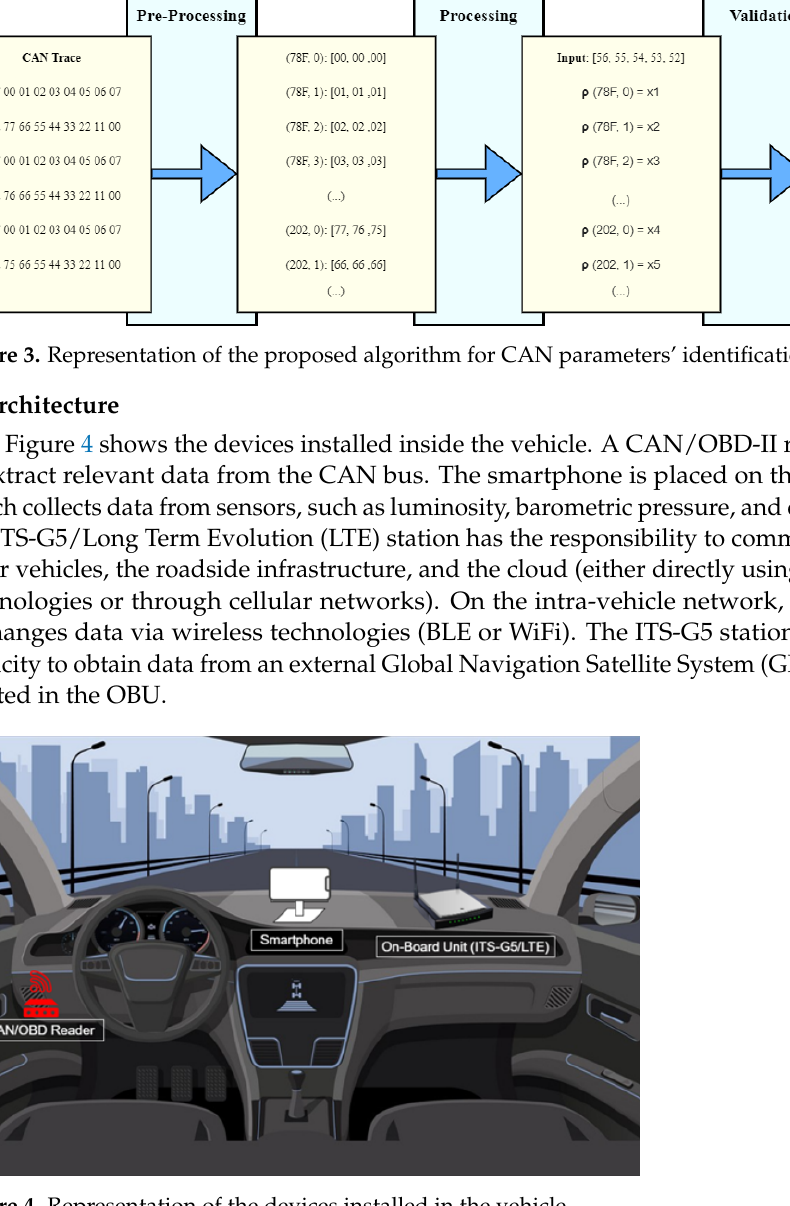
Figure 4. Representation of the devices installed in the